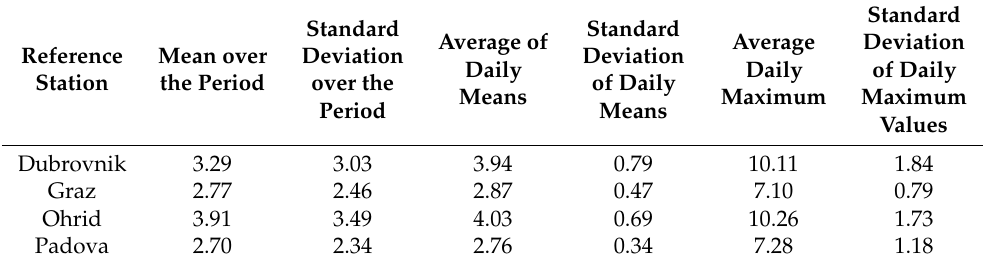
Table 3. Statistics of vertical GPS ionospheric delays during days 100–120 in